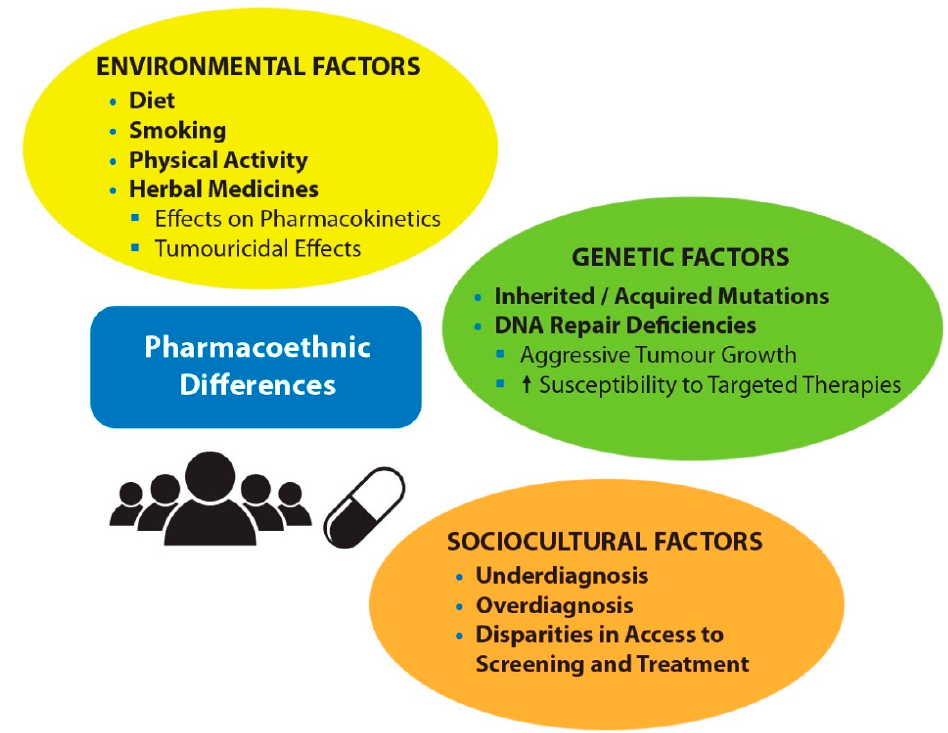
Figure 1. Factors that may contribute toward pharmacoethnic differences in the management of Asian mPC patients.